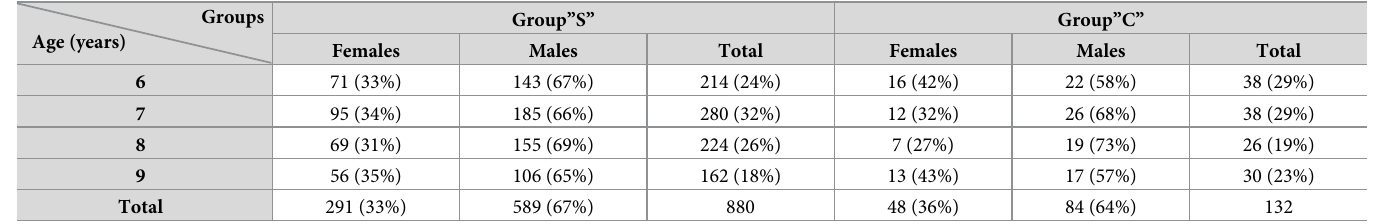
Table 1. Size and percentage of sex distribution in study and control groups, by age group.